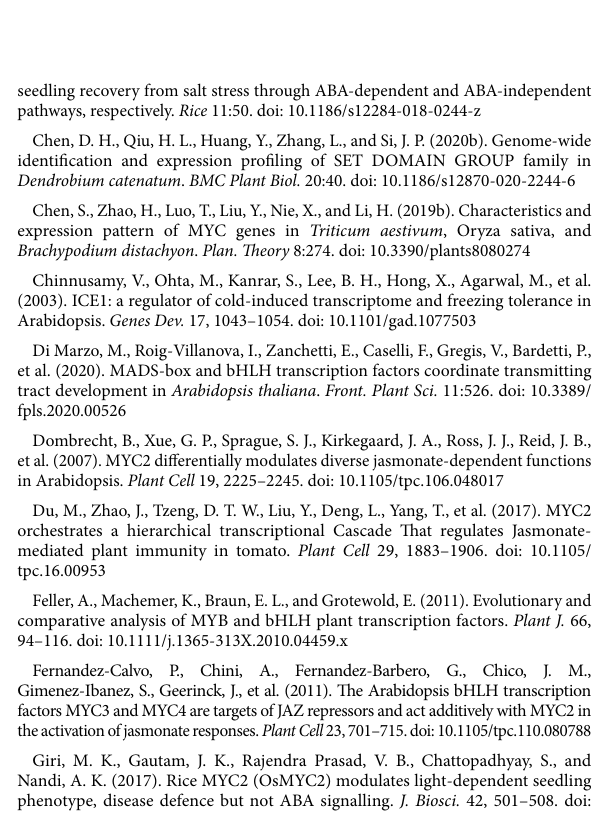
SUPPLEMENTARY FIGURE S1 Cis-acting elements in the 1,500 bp promoter regions of the DcbHLH genes. Different color boxes represent different clades. Solid boxes of different colors represent different cis-acting elements, and the legend is on the right side of the